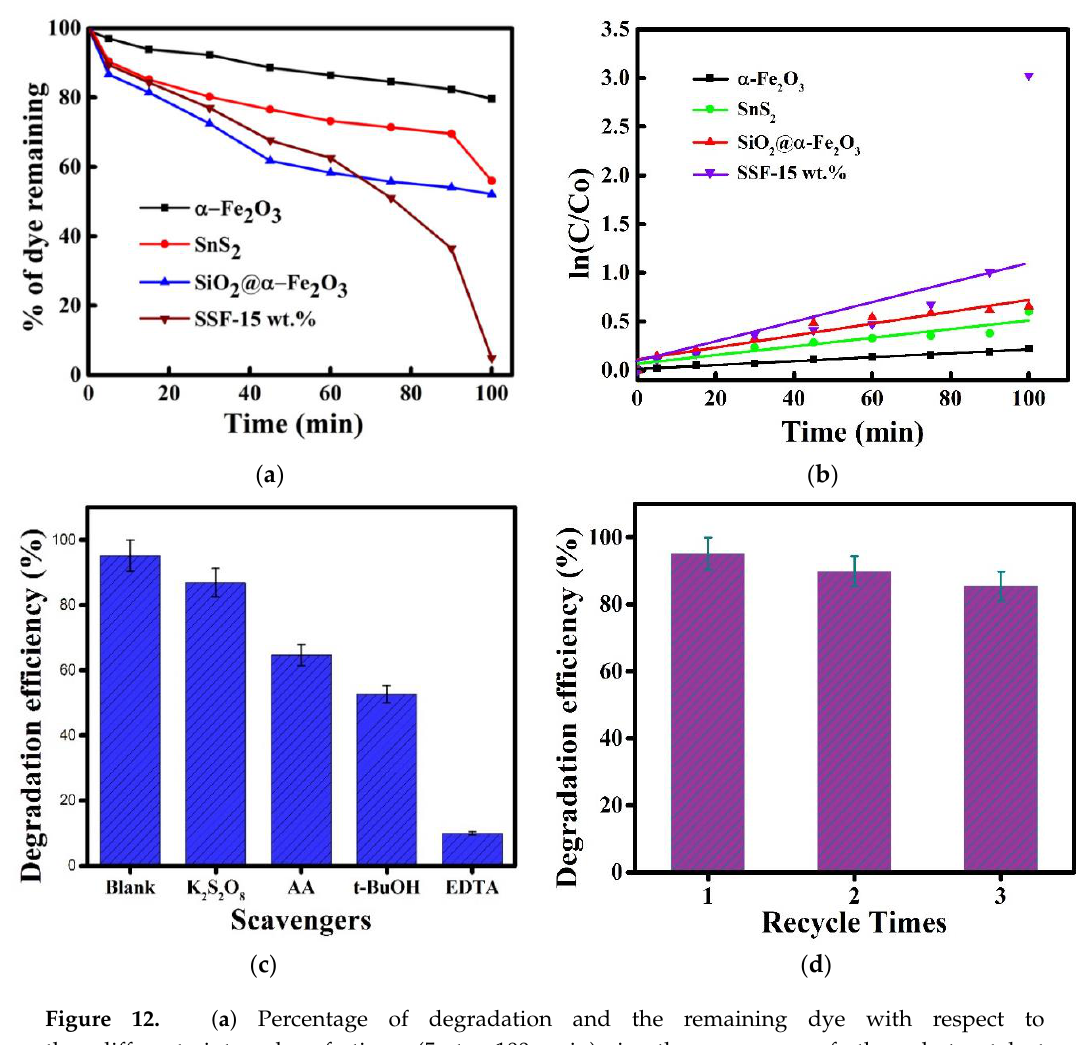
Figure 12. ( a ) Percentage of degradation and the remaining dye with respect to the different intervals ( a ) Percentage of degradation and the remaining dye with respect to of time (5 to 100 min ) in the presence of the photocatalyst α -Fe 2 O 3 /SnS 2 /SiO 2 @α -Fe 2 O 3 /SnS 2 -SiO 2 @α - the different intervals of time (5 to 100 min) in the presence of the photocatalyst Fe 2 O 3 under irradiation by visible light. ( b ) Plot of ln (C/C o ) vs time. ( c ) Photodegradation efficiency α -Fe α -Fe α -Fe 2 O 3 /SnS 2 /SiO 2 @ 2 O 3 /SnS 2 -SiO 2 @ 2 O 3 under irradiation by visible light. ( b ) Plot of SSF-15 wt % in the presence of different active-species (scavengers). ( d ) Reusability of the SSF-15 of ln (C/C o ) vs time. ( c ) Photodegradation efficiency of SSF-15 wt % in the presence of different wt % nanocomposite. active-species (scavengers). ( d ) Reusability of the SSF-15 wt %